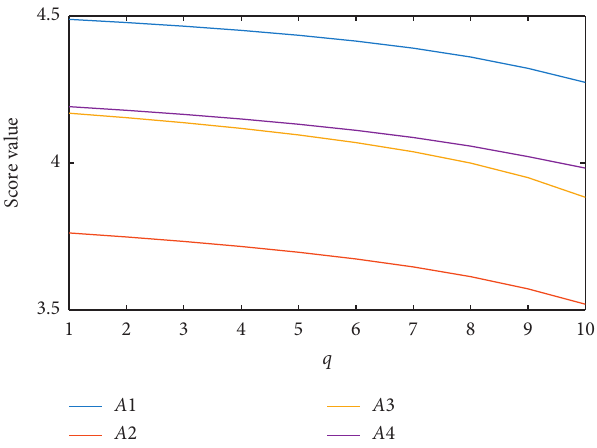
Figure 6: Scores of A ( i � 1 , 2 , 3 , 4 ) when p � 1 and q ∈ [ 0 , 10 ]( θ � 5 ) . i